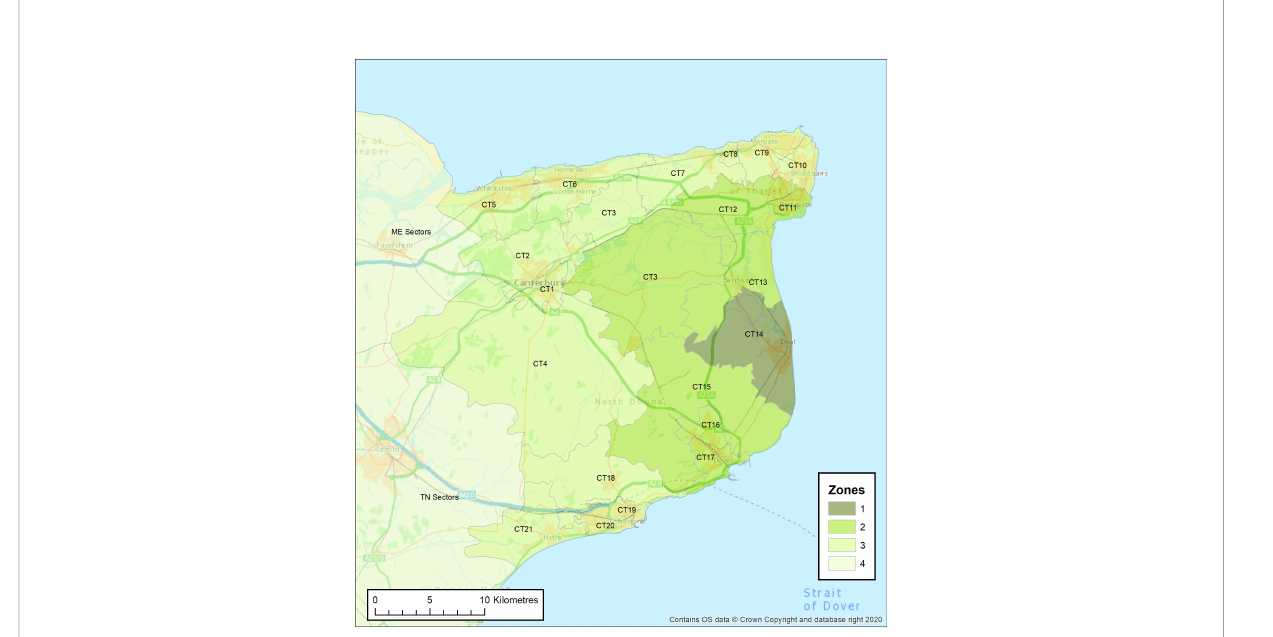
FIGURE 1 Map of the postcode areas in Kent grouped in 5 residential zones according to distance from Deal (Zone 5 is not represented on the